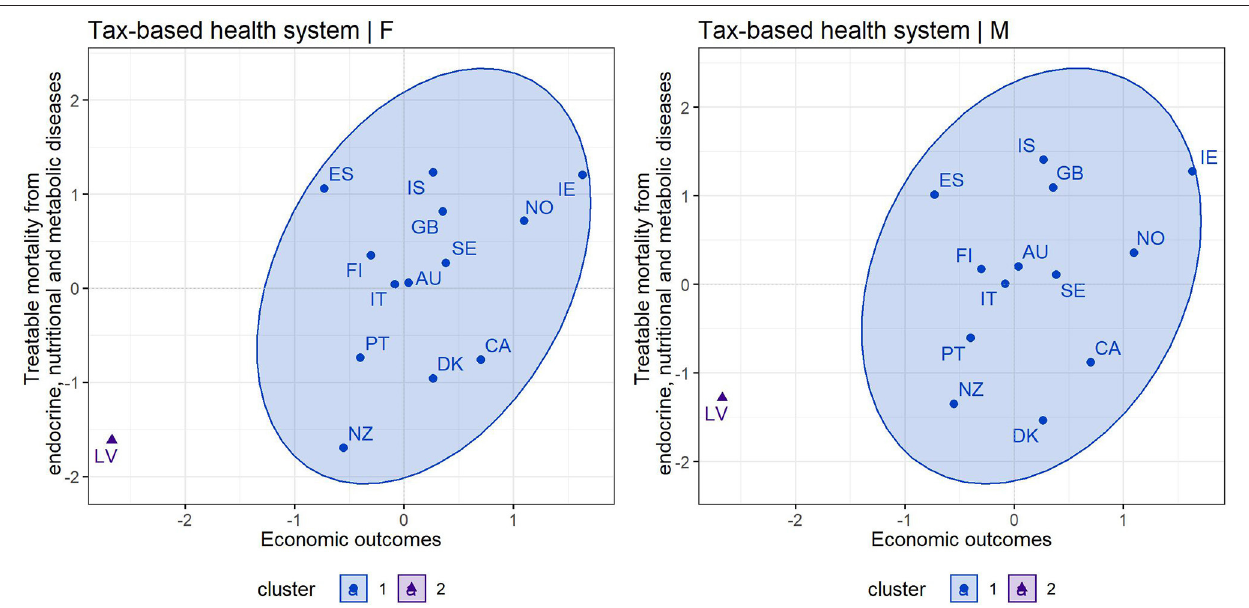
FIGURE 3 | Cluster map—economic outcomes and treatable mortality from endocrine, nutritional and metabolic diseases for countries applying a tax-based health system—females (F) and males (M).